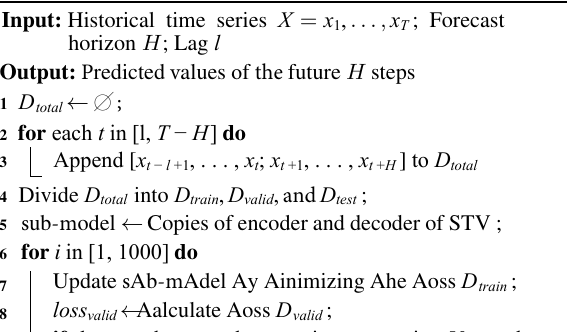
Algorithm 1 STV training and